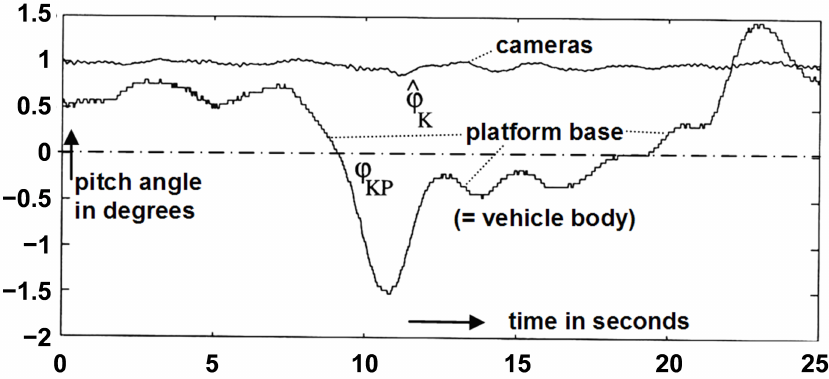
Figure 17. Inertial gaze stabilization for a braking maneuver with